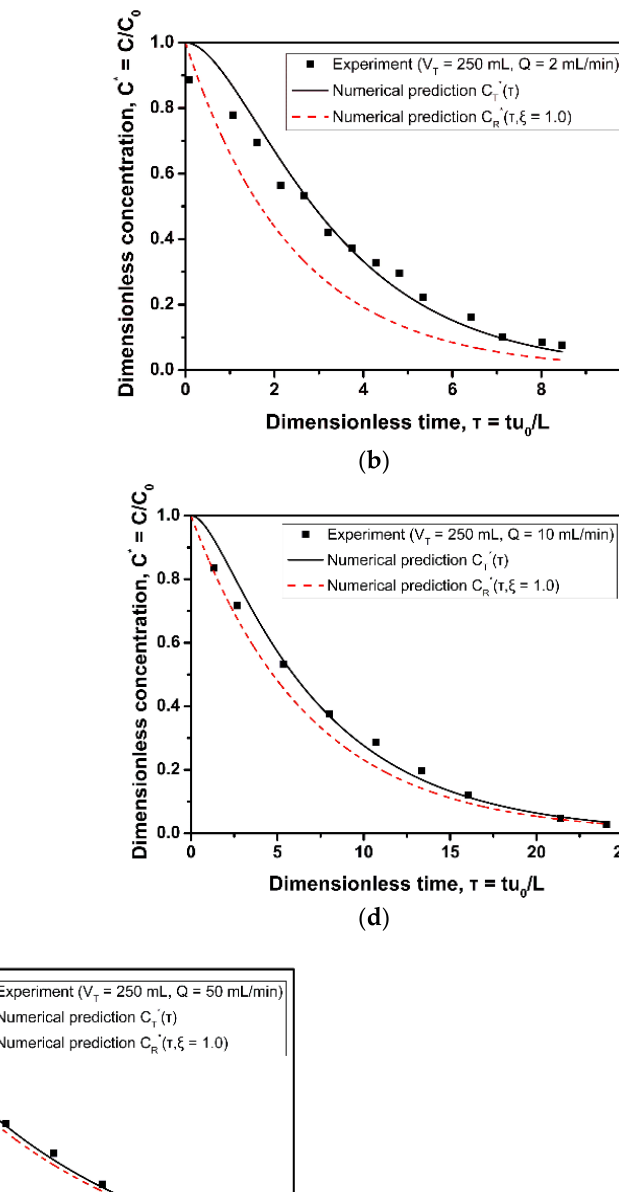
Figure A1. Comparison of numerical prediction with experimental measurements of the transient response of phenol concentration in continuous flow PMMA photoreactor for various values of the flow rate and liquid volume in recycle tank. ( a ) V T = 105 mL, Q = 2 mL/min; ( b ) V T = 210 mL, Q = 2 mL/min; ( c ) V T = 310 mL, Q = 2 mL/min; ( d ) V T = 105 mL, Q = 10 mL/min; ( e ) V T = 105 mL, Q = 50 mL/min.